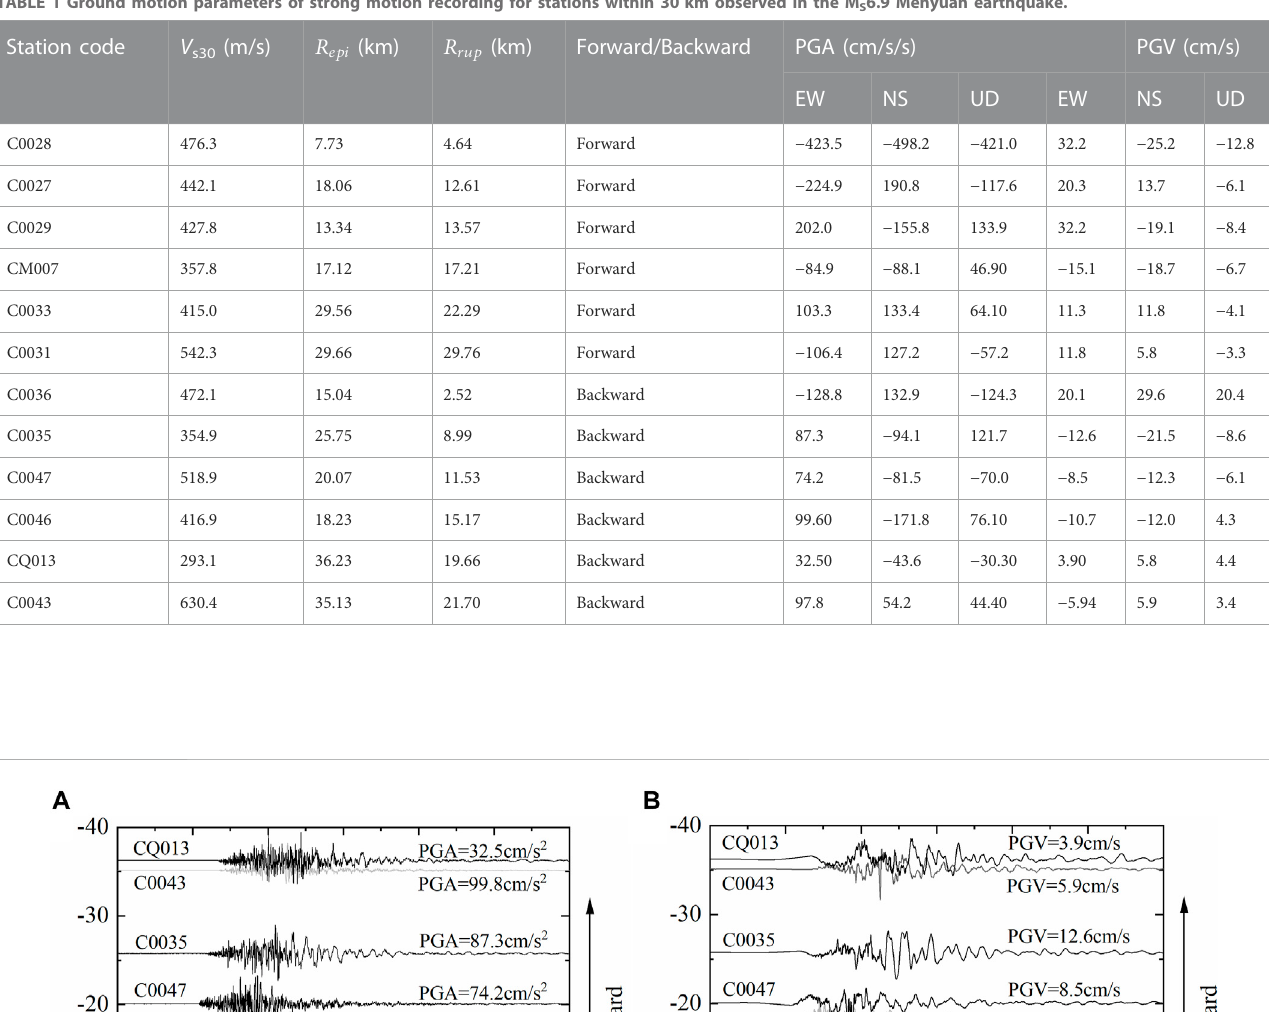
Frontiers in Earth